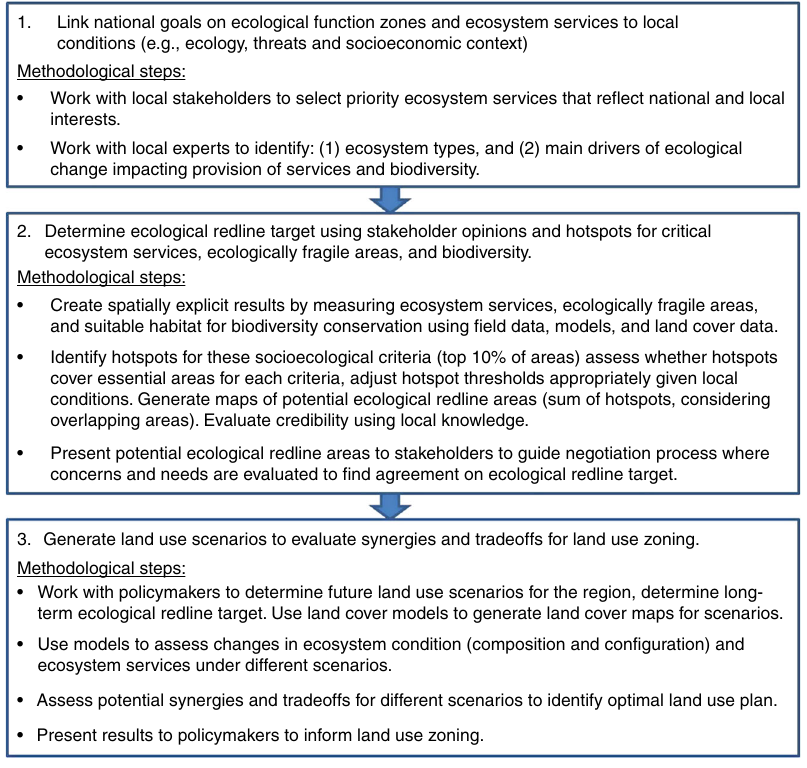
Table 1 Indicators and data to determine the ERAs for 2014 in Shanghai Municipality Criteria Indicators Main data Ecosystem services hotspots